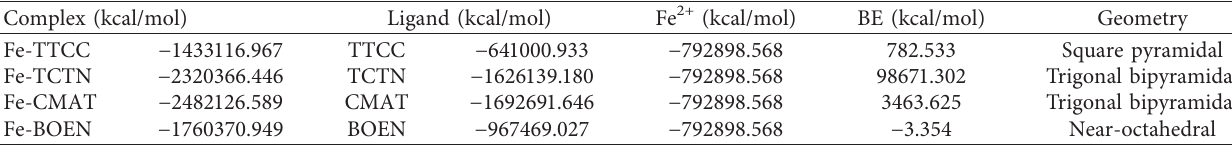
Figure 3: Complexes of the studied chemicals with Fe 2+ . (a) Fe-TTCC. (b) Fe-TCTN. (c) Fe-CMAT. (d) Fe-BOEN. Table 2: Calculated binding energies (BE) of the studied novel